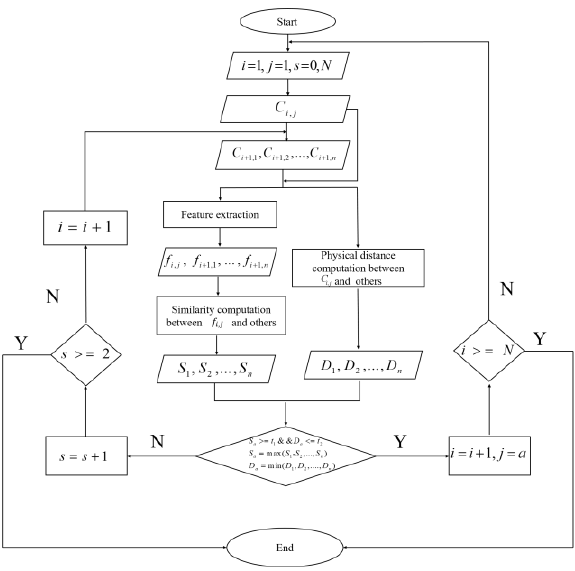
Figure 3. Cluster tracking